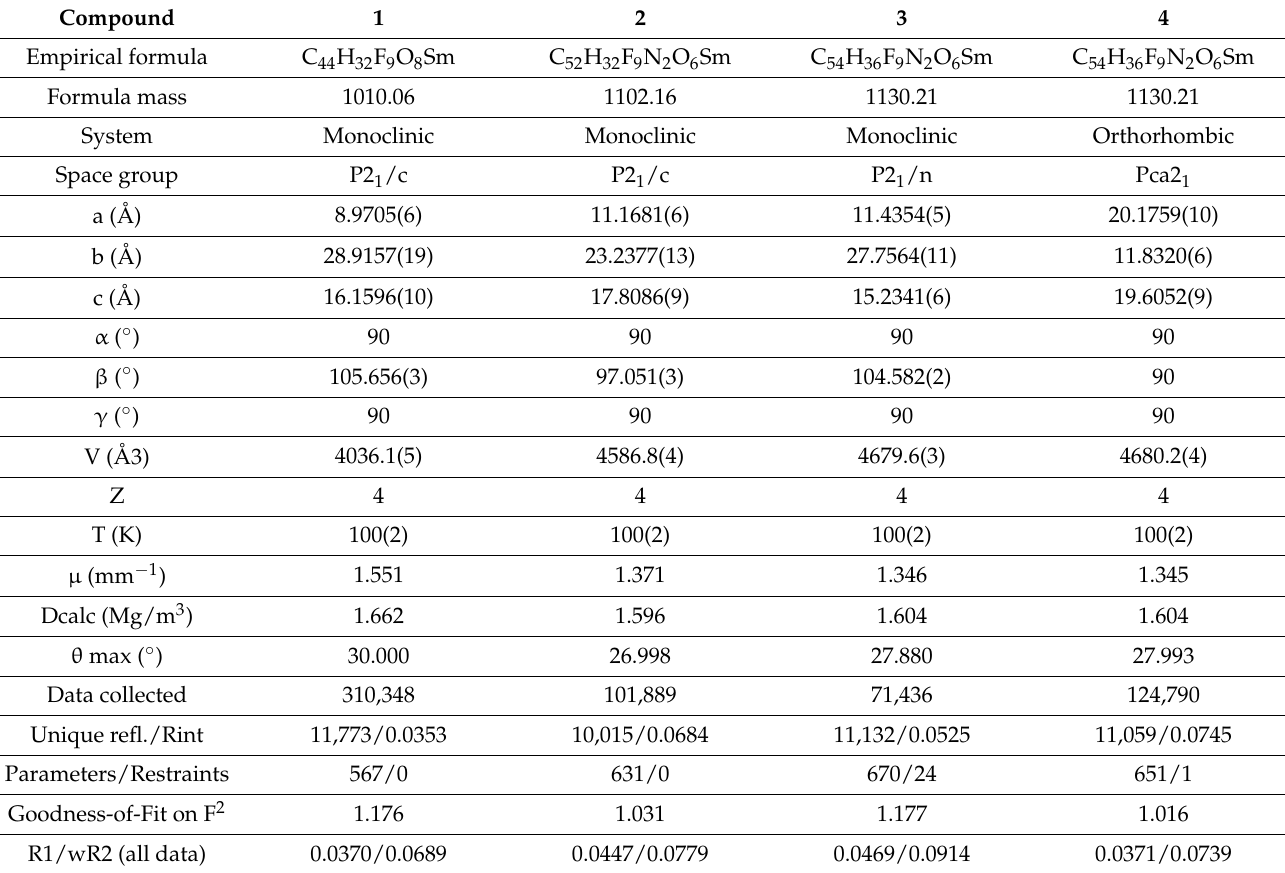
Table 1. Crystallographic data and processing parameters for 1 – 4